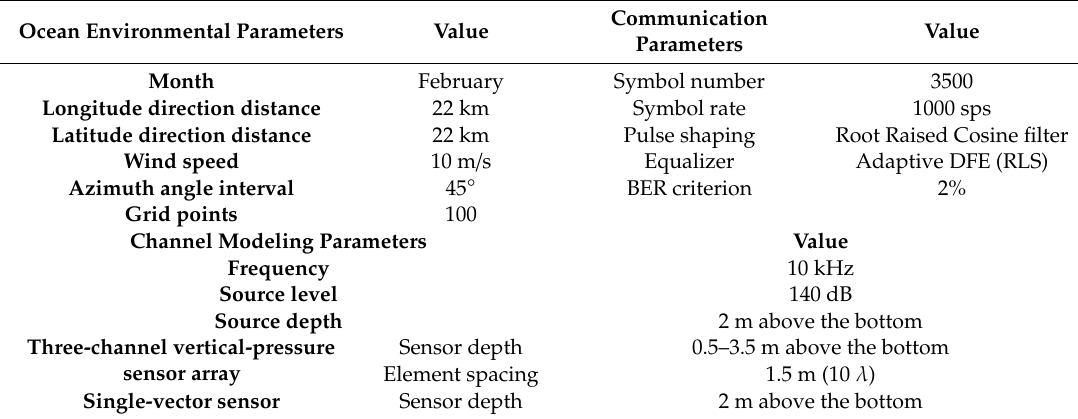
Table 1. The parameters used for the communication PS simulation.